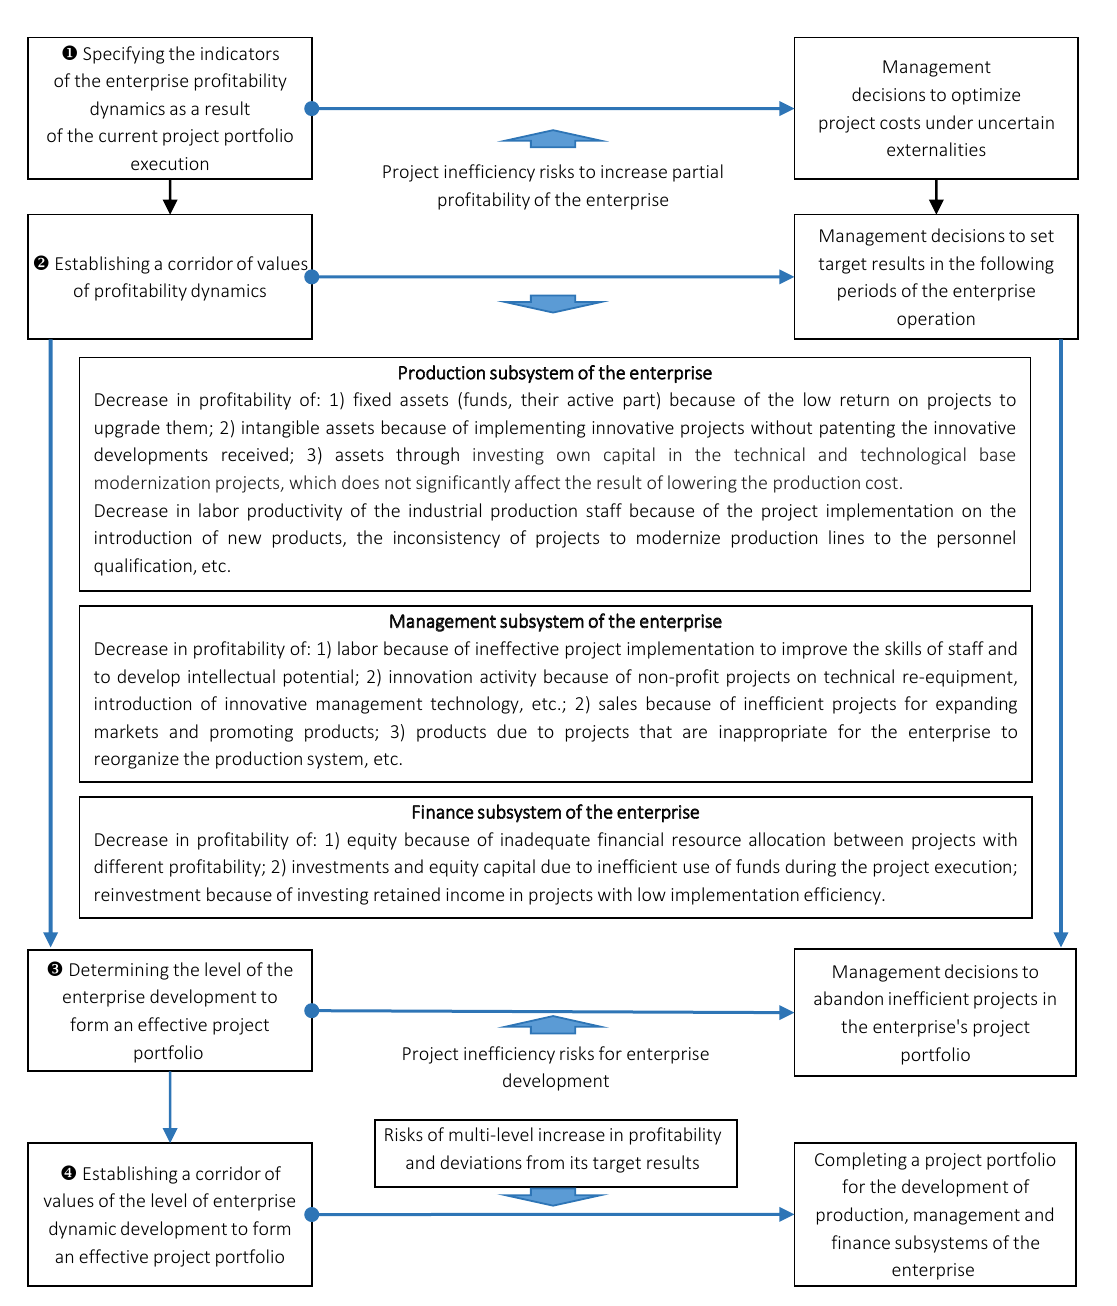
Figure 1. Structural-logical scheme of economic and management approach to defining